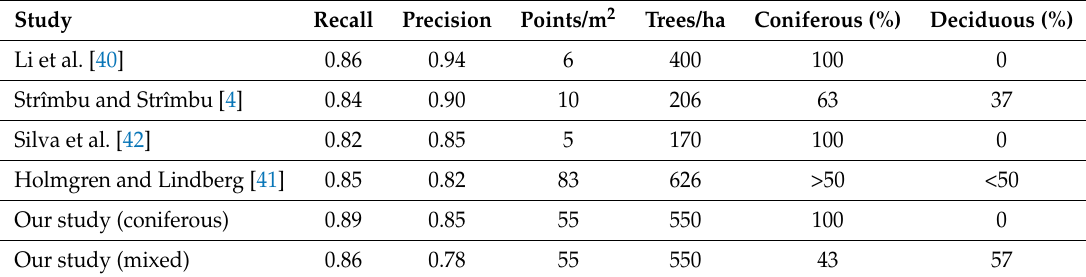
Table 17. Parameters and accuracy performance of tree segmentations methods compared with our study. Note that recall and precision values were evaluated from field measurements of HTO